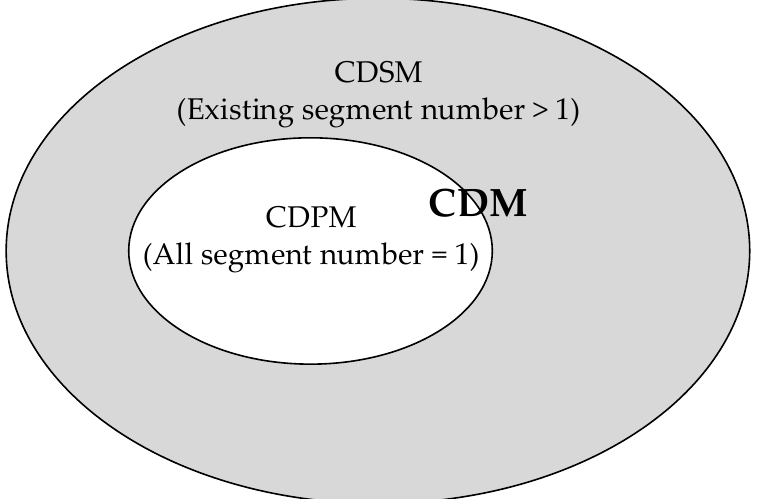
Figure 1. The relationship among CDM (cable-driven manipulator), CDSM (cable-driven serial manipulator), and CDPM (cable-driven parallel manipulator) from the perspective of the cable’s segment number.